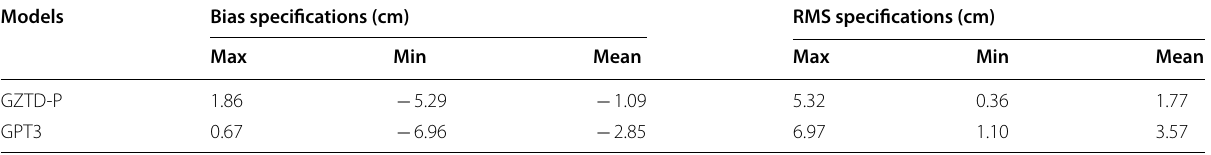
Table 3 The performance of the GZTD-P and GPT3 models validated with MERRA-2 data Models